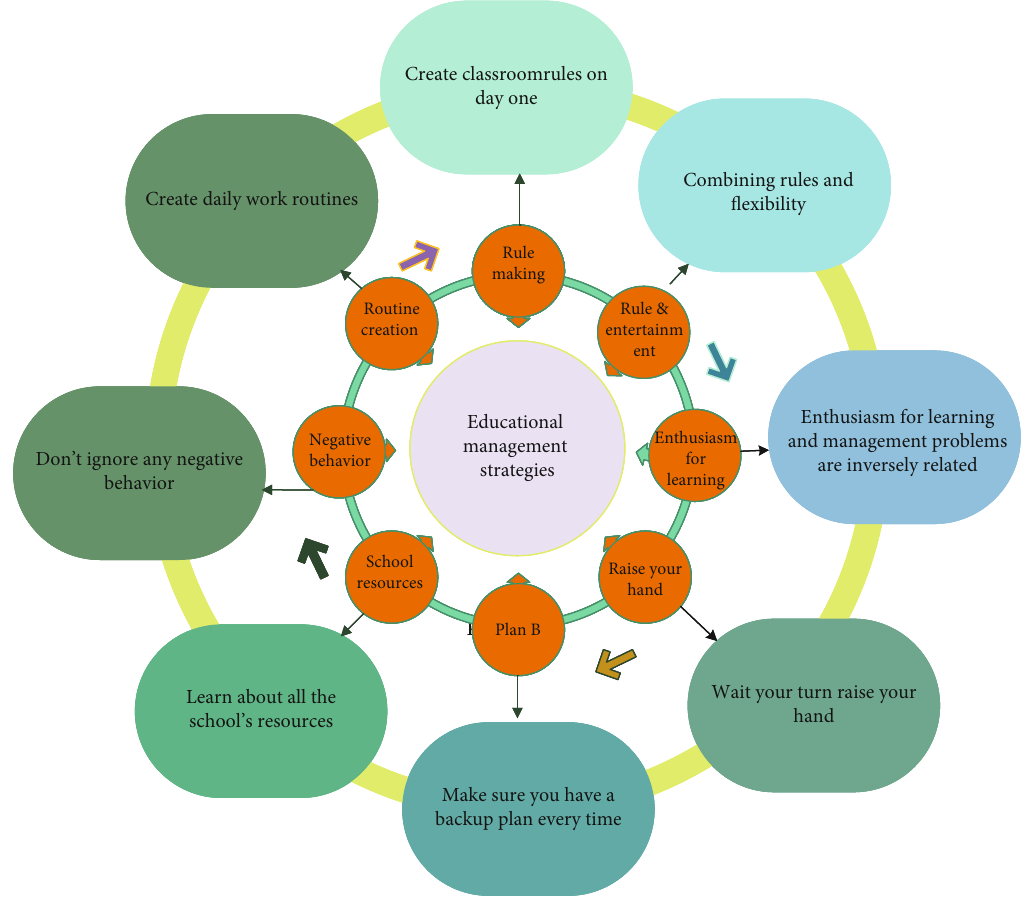
Figure 2: Education management